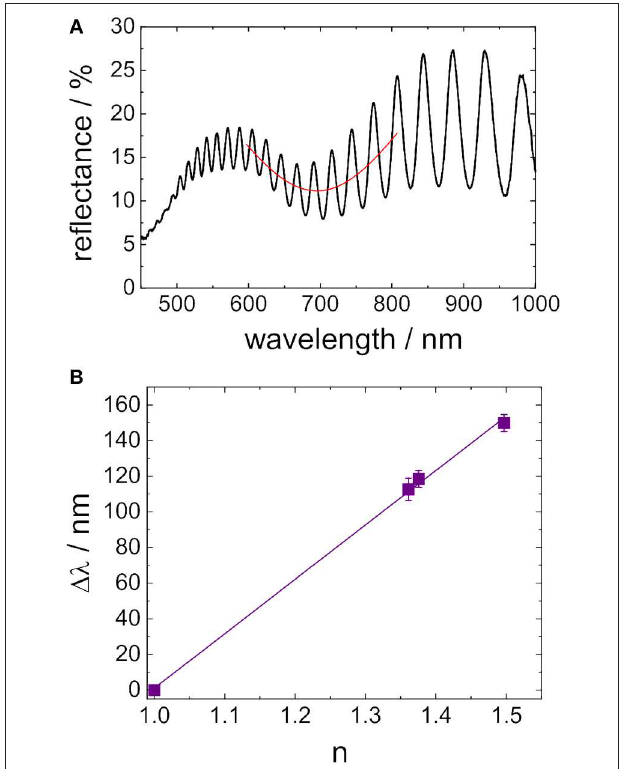
FIGURE 6 | (A) Reflectance spectra of hybrid sensors composed of gold nanostructures and porous silicon (red lines are integrated in order to guide the eye to the LSPR feature in the spectrum). (B) Plot of the position of LSPR on the wavelength scale vs. the refractive index of the medium surrounding the